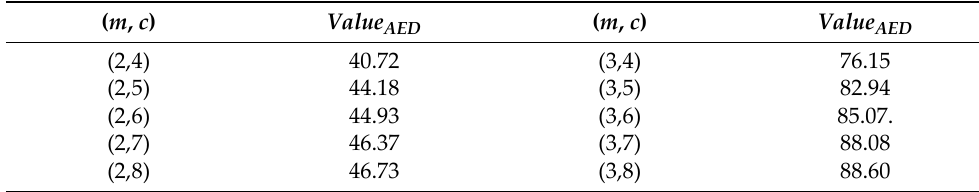
Figure 9. Accelerometers installation location.